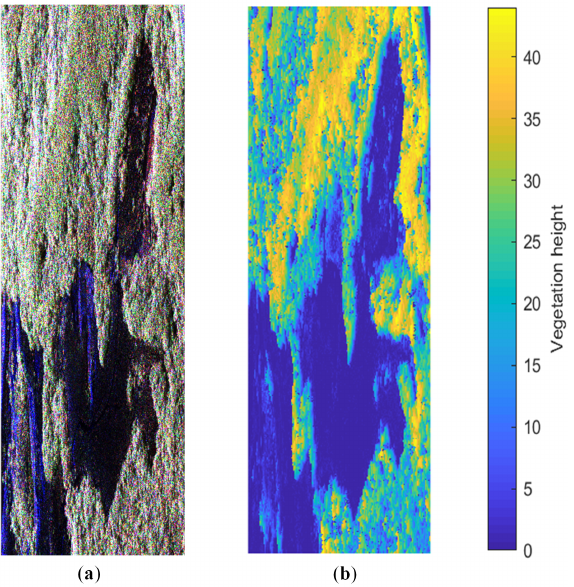
Figure 9. ( a ) The Pauli image and ( b ) the LVIS RH100 height image of the interested